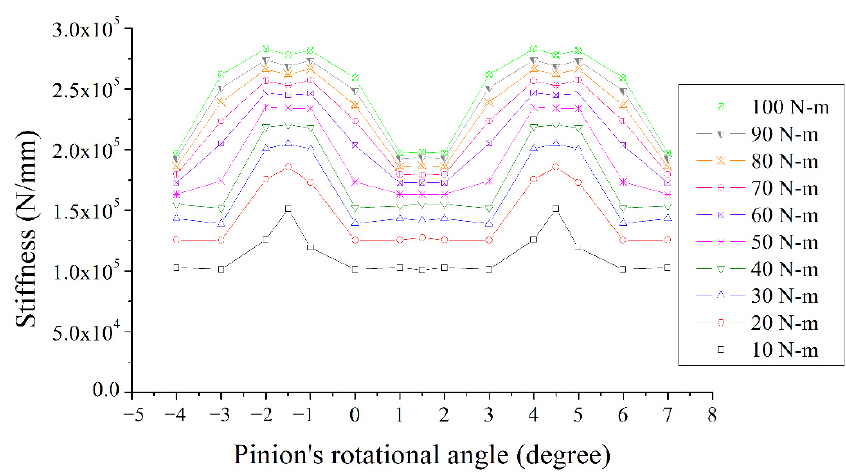
Figure 5. Mesh stiffness under different loads.